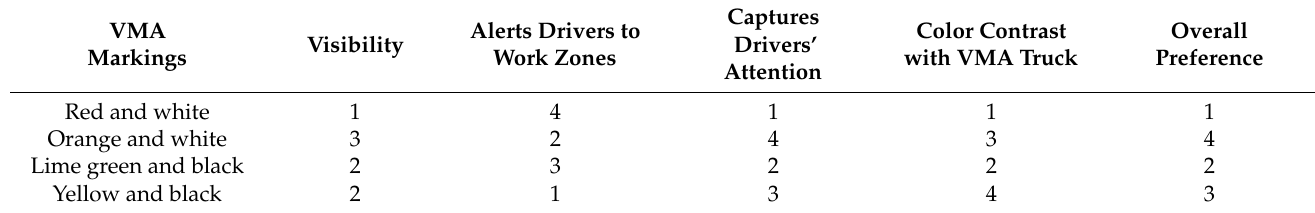
Table 9. Performance rating of four VMA markings (1 = best, 4 = worst; [39]). Captures VMA Alerts Drivers to Color Contrast Overall Visibility Drivers’ Markings Work Zones with VMA Truck Preference Attention Red and white 1 4 1 1 1 Orange and white 3 2 4 3 4 Lime green and black 2 3 2 2 2 Yellow and black 2 1 3 4 3 A review of work zone requirements by various DOTs indicated that the black-and- yellow inverted ‘V’ chevron marking is most widely used However, Virginia’s Department of Transportation standard requires the rear panel of the TMA cushion to have alternating 6-to-8-inch-wide orange and black or yellow and black inverted ‘V’ chevron stripes. Stripes should slope downward at a 45-degree angle in both directions from the upper center of the rear panel. Additionally, stripes should be fabricated from fluorescent orange or yellow retroreflective sheeting in compliance with Section 247 of the Road and Bridge Specifications [31]. A summary of the TMA chevron colors for some DOTs is presented in Table